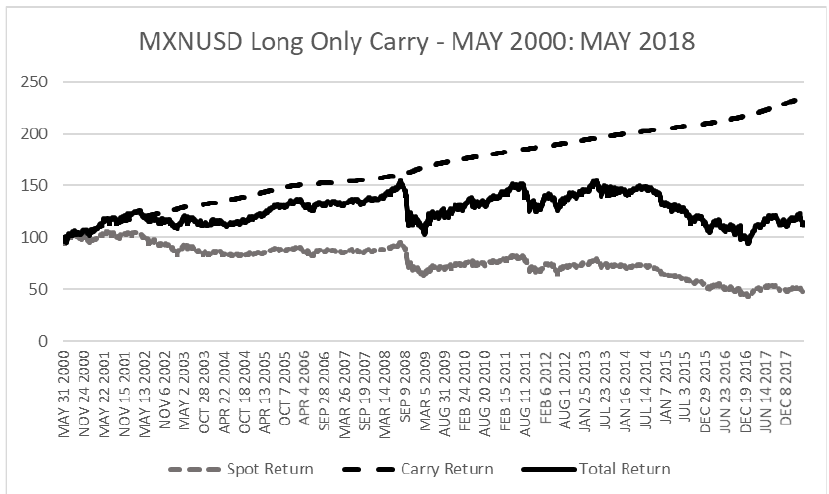
Figure 1 . MXNUSD Long Only Carry. Source: Authors elaboration from financial series extracted from Bloomberg.